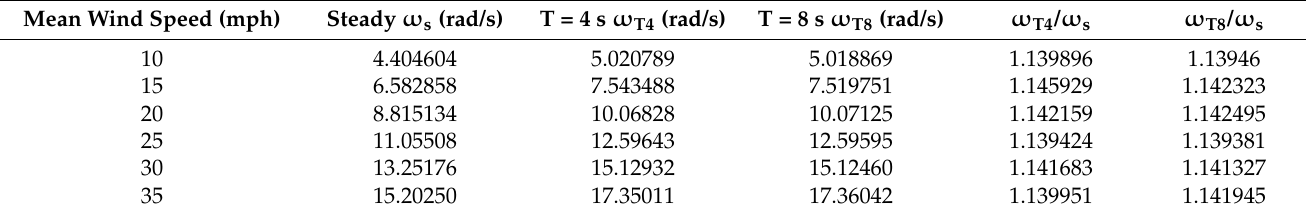
Table 2. The ratios between the angular velocities of the rotor driven by steady and periodic wind.